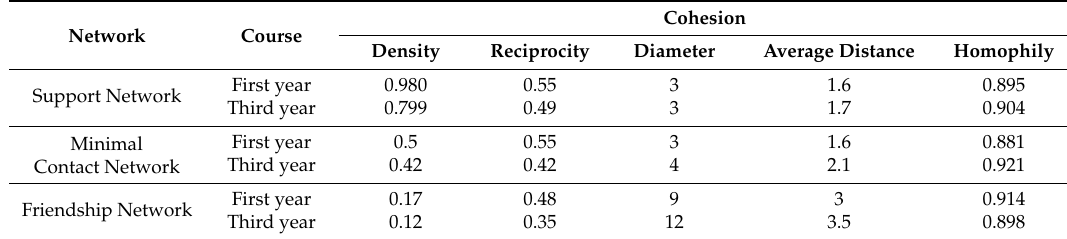
Table 3. Descriptive indicators of the cohesion in networks from the first and third